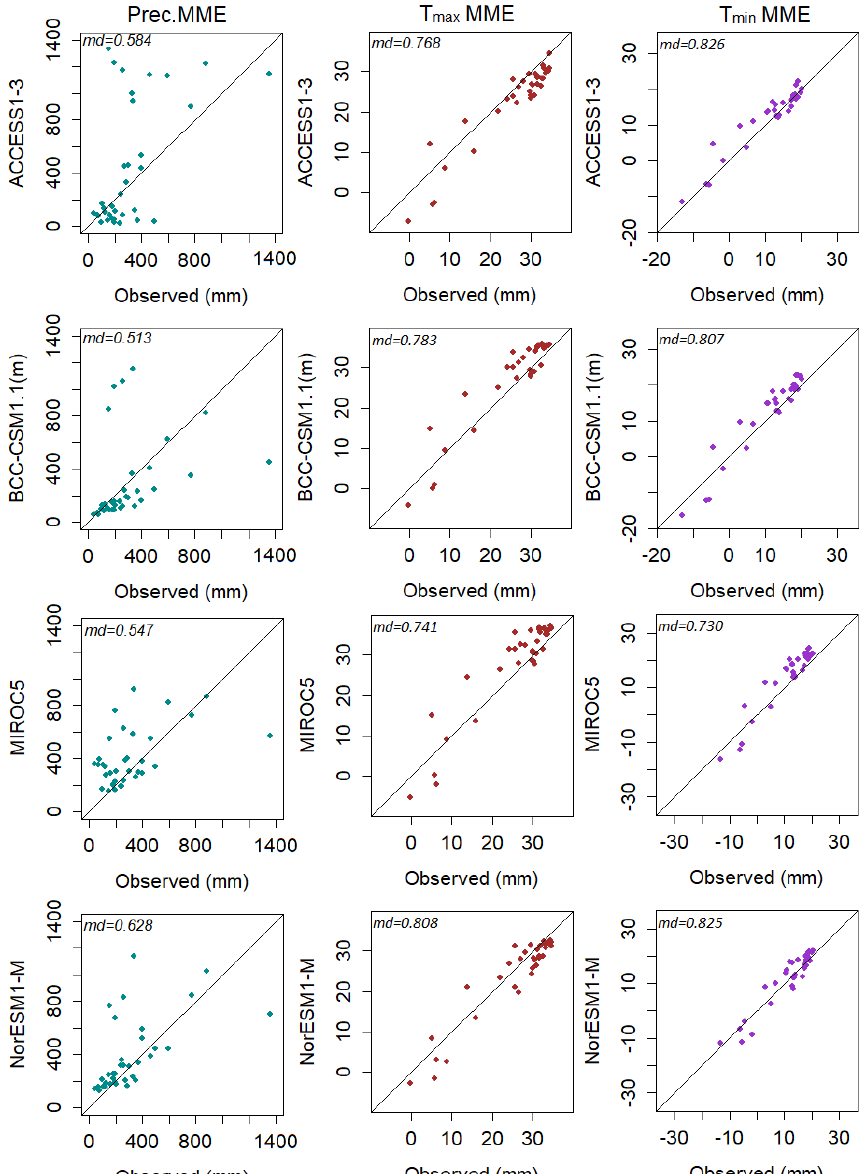
Figure 4. Scatter of spatially averaged annual P , T max and T min of four top-ranked GCMs plotted against GPCC P , CRU T max , and CRU T min for the period 1961 to